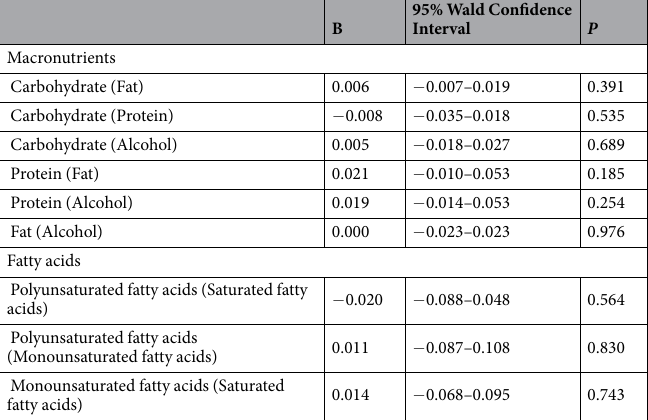
Table 5. Association between LPS activity and dietary macronutrient intake (substitution model) in 542 individuals. In each model, all but one macronutrient (the one in the parenthesis) is included together with energy intake and selected covariates (sample storage time, age, sex, smoking, physical activity, and diabetic nephropathy status). The models with fatty acids, are additionally corrected for trans fatty acid intake. The B represents an increase or decrease in the LPS activity when, in an isoenergetic condition, the intake of a given macronutrient or fatty acid is increased by 5 per cent of the total energy intake, at the expense of the macronutrient or fatty acid in the parenthesis. Thus in the first row, for example, the B shows the (non- significant) increase in the LPS activity when carbohydrate intake is increased by 5 per cent of the total energy intake at the expense of fat intake, while keeping the energy intake constant. Data on energy and nutrient intakes have been obtained from the food records. Generalized linear